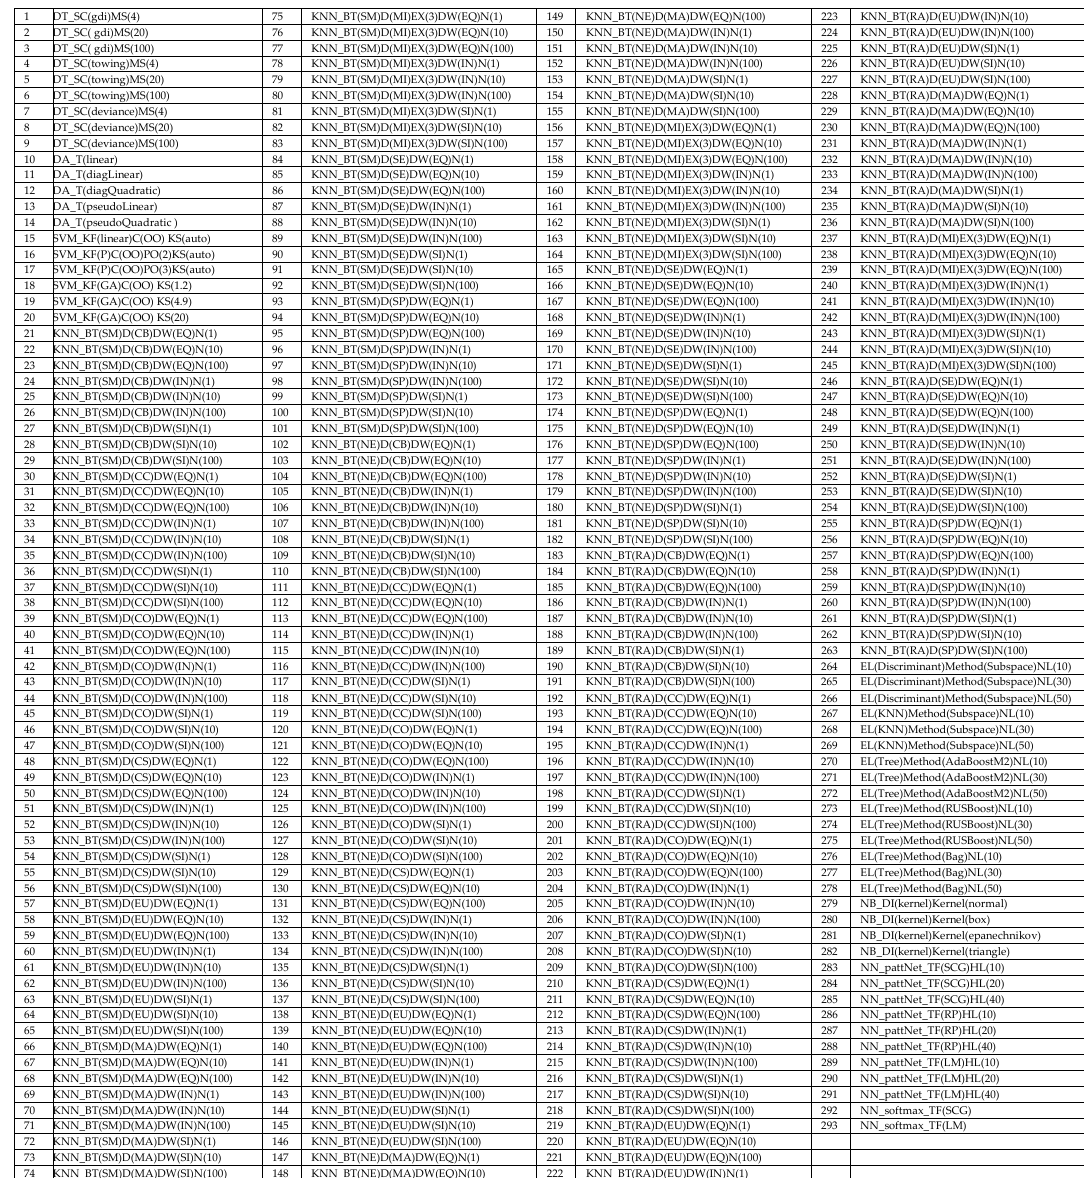
22 of 26 In training the network, its parameters are adjusted incrementally until difference between the output units and the target values is minimized. Resilient backpropagation [65], scaled conjugate gradient [66] and Levenberg–Marquardt backpropagation are the most well-known network training algorithms. For example, Levenberg–Marquardt optimization uses the Hessian matrix approximation, (cid:1836) (cid:3021) (cid:1836) , in the following Newton-like update [45]: (cid:1875) (cid:3036) ((cid:1872) + 1) = (cid:1875) (cid:3036) ((cid:1872)) − [(cid:1836) (cid:3021) (cid:1836) + (cid:2020)(cid:1835)] (cid:2879)(cid:2869) (cid:1836) (cid:3021) (cid:1857) where Jacobian matrix J holds the first derivatives of the network errors in respect of the weights and biases. µ stands for an adjustment factor, e for a vector of network errors and I for the identity matrix